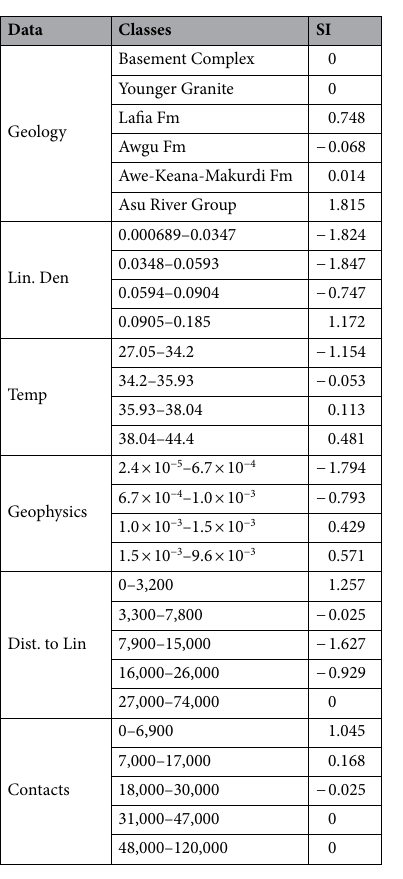
Table 2. Parameter weighting by application of statistical